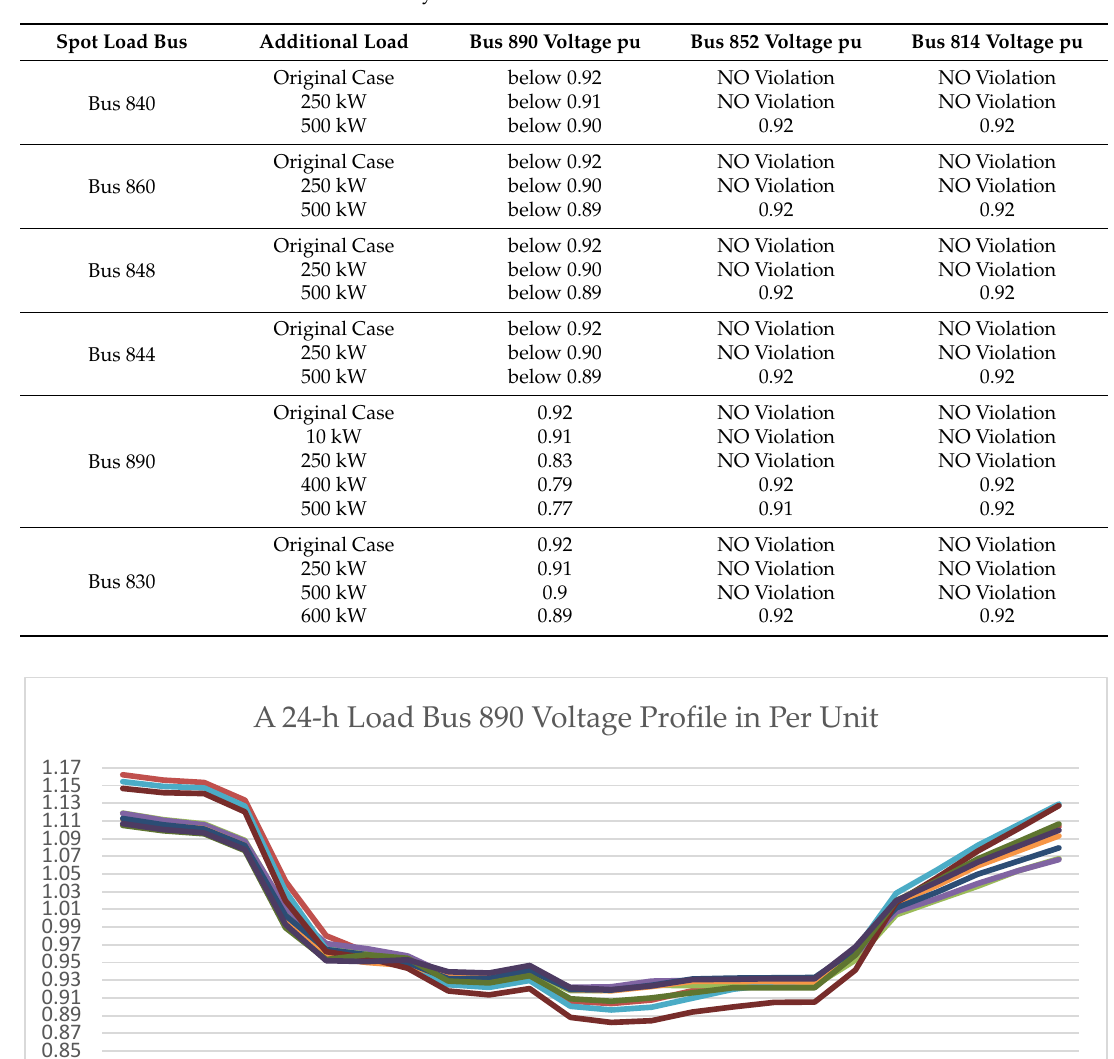
Table 5. Summary of Case 1 buses Maximum Additional Load.